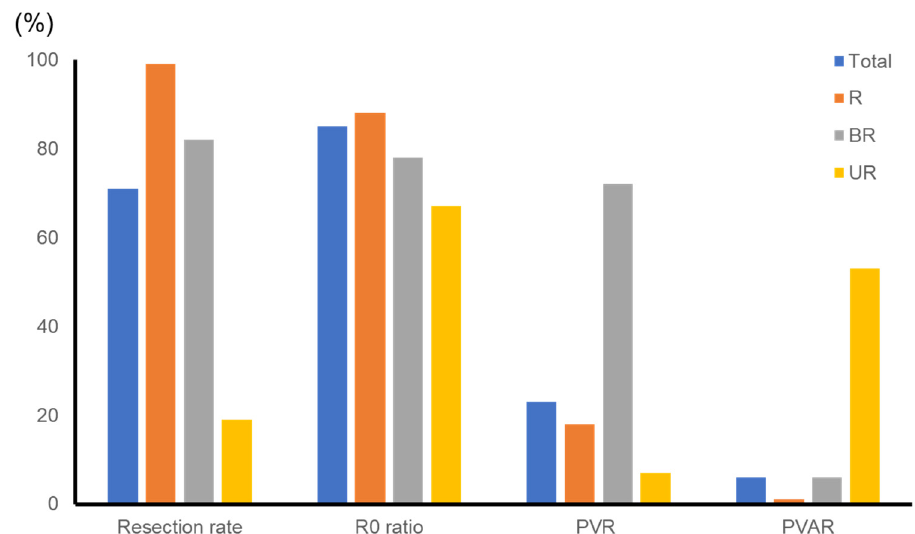
Figure 1. Total resection rate and status and combined vascular resection. R: resectable, BR: bor- derline resectable, UR: unresectable, PVR: portal/superior mesenteric vein resection, PVAR: both portal/superior mesenteric vein and arterial resection.